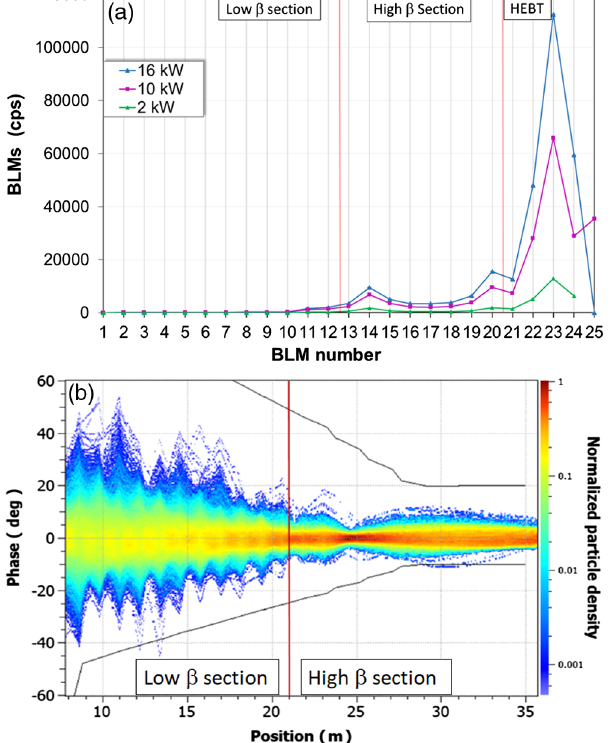
FIG. 16. (a) Count rate for each BLM at 16 kW (blue), 10 kW (violet), and 2 kW (green) beam power and (b) beam density in the longitudinal plane of a proton beam. Dark lines are the ϕ s and − 2 ϕ s limits.